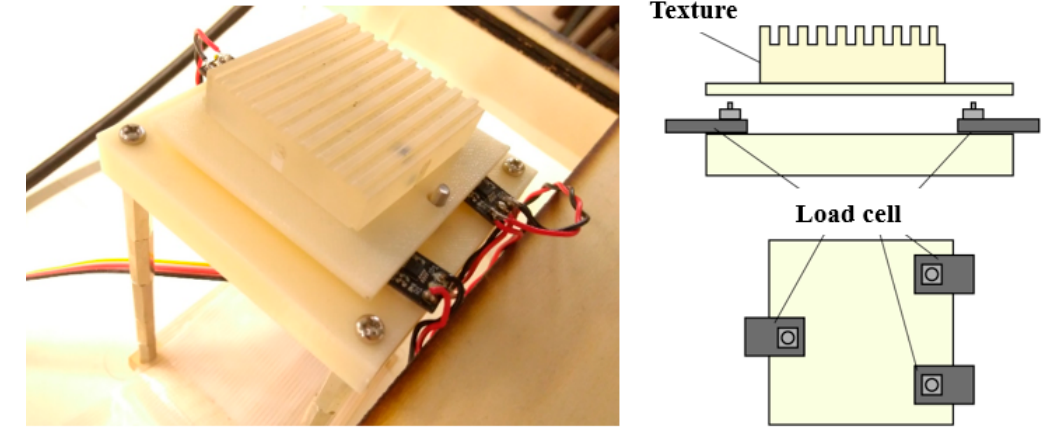
Figure 2. Texture pedestal (left). Three load cells were placed under the plate (right).